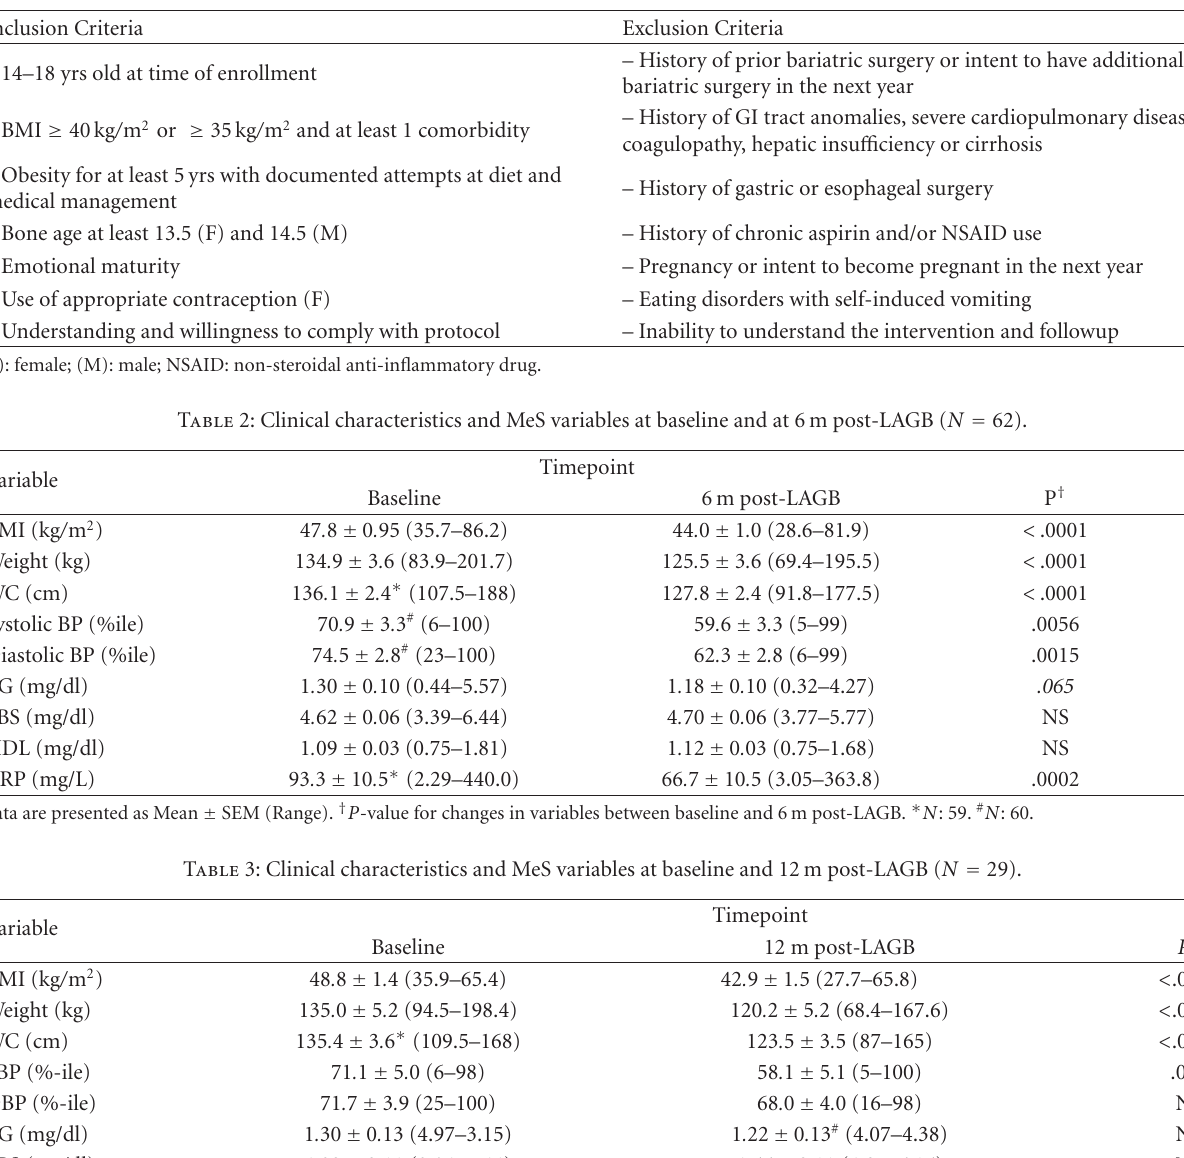
Table 1: Patient selection criteria.